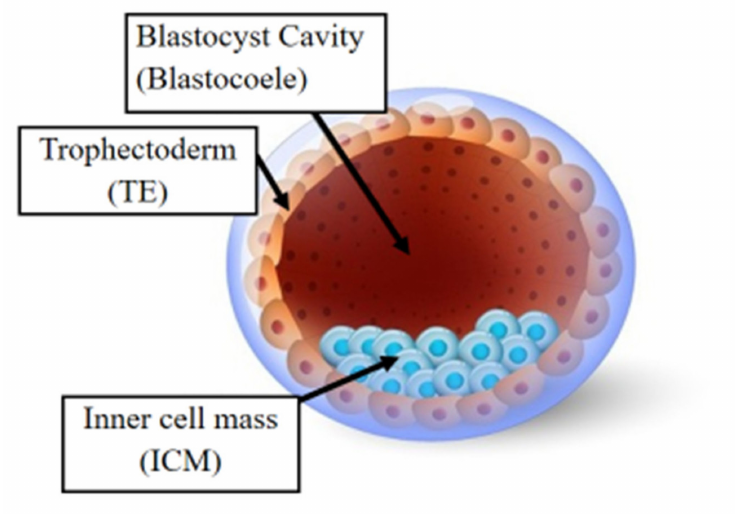
Figure 2. The human blastocyst. The structure comprises two differentiated cell types and a central cavity filled with fluid (blastocoel cavity). The inner cell mass (ICM) becomes the fetus and the trophectoderm (TE) cells later develop into the